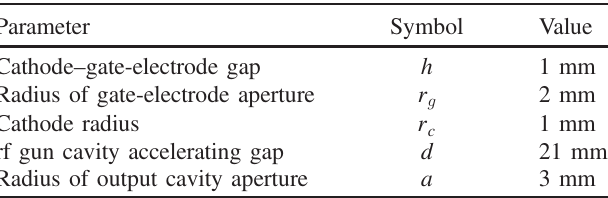
TABLE IV. The parameters of the paraxial region of the gun.